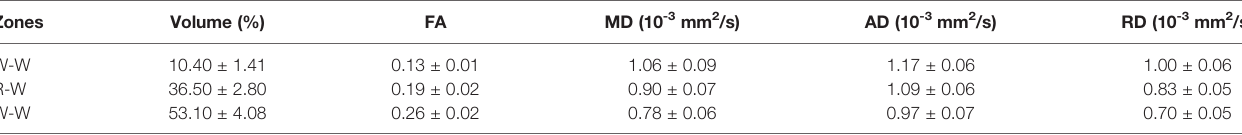
TABLE 1 | The volumes and DTI metrics at different zones of meniscus.